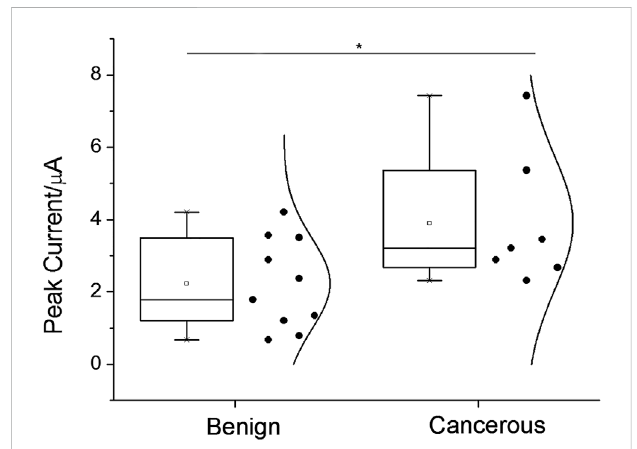
FIGURE 5 Assay-graded clinical samples ’ square-wave voltammetric signal responses were displayed as data distributions for the osteosarcoma condition group and the benign condition group, respectively. Asterisks signify statistical differences of more than